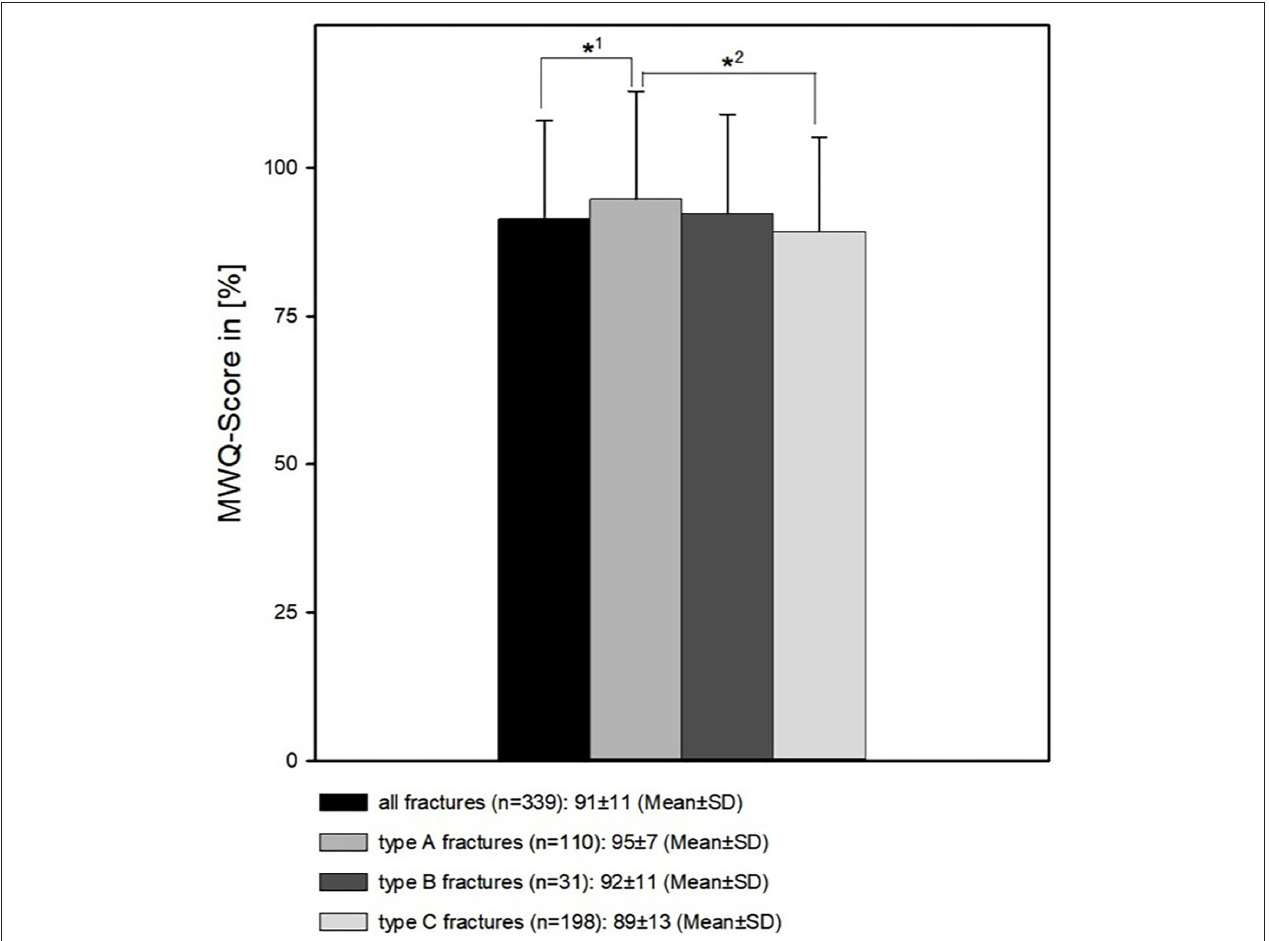
FIGURE 8 | Patients’ wrist function in respect to the different fracture types. *2 The function of type A fractures is significantly better than type C fractures (95 ± 7% vs. 89 ± 13%, p < 0.05 MWUT). *1 The function of type A fractures is significantly better than the results from the whole fracture register (95 ± 7% vs. 91 ± 11%, p < 0.05